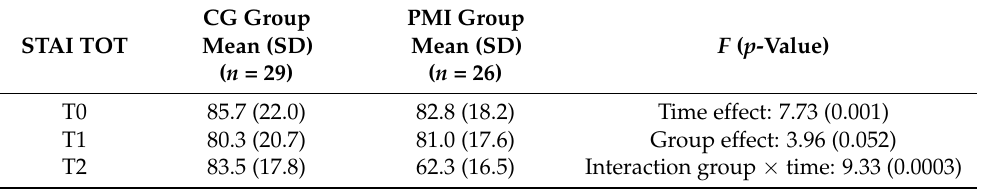
Table 2. Primary outcome: anxiety (STAI TOT).